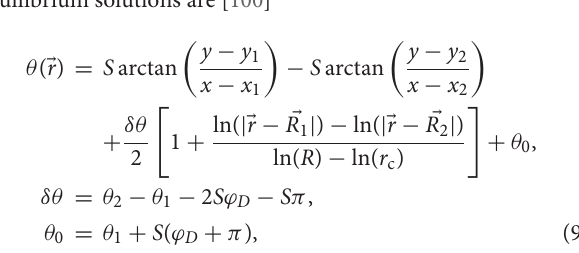
interacting defects is the only director field deformation